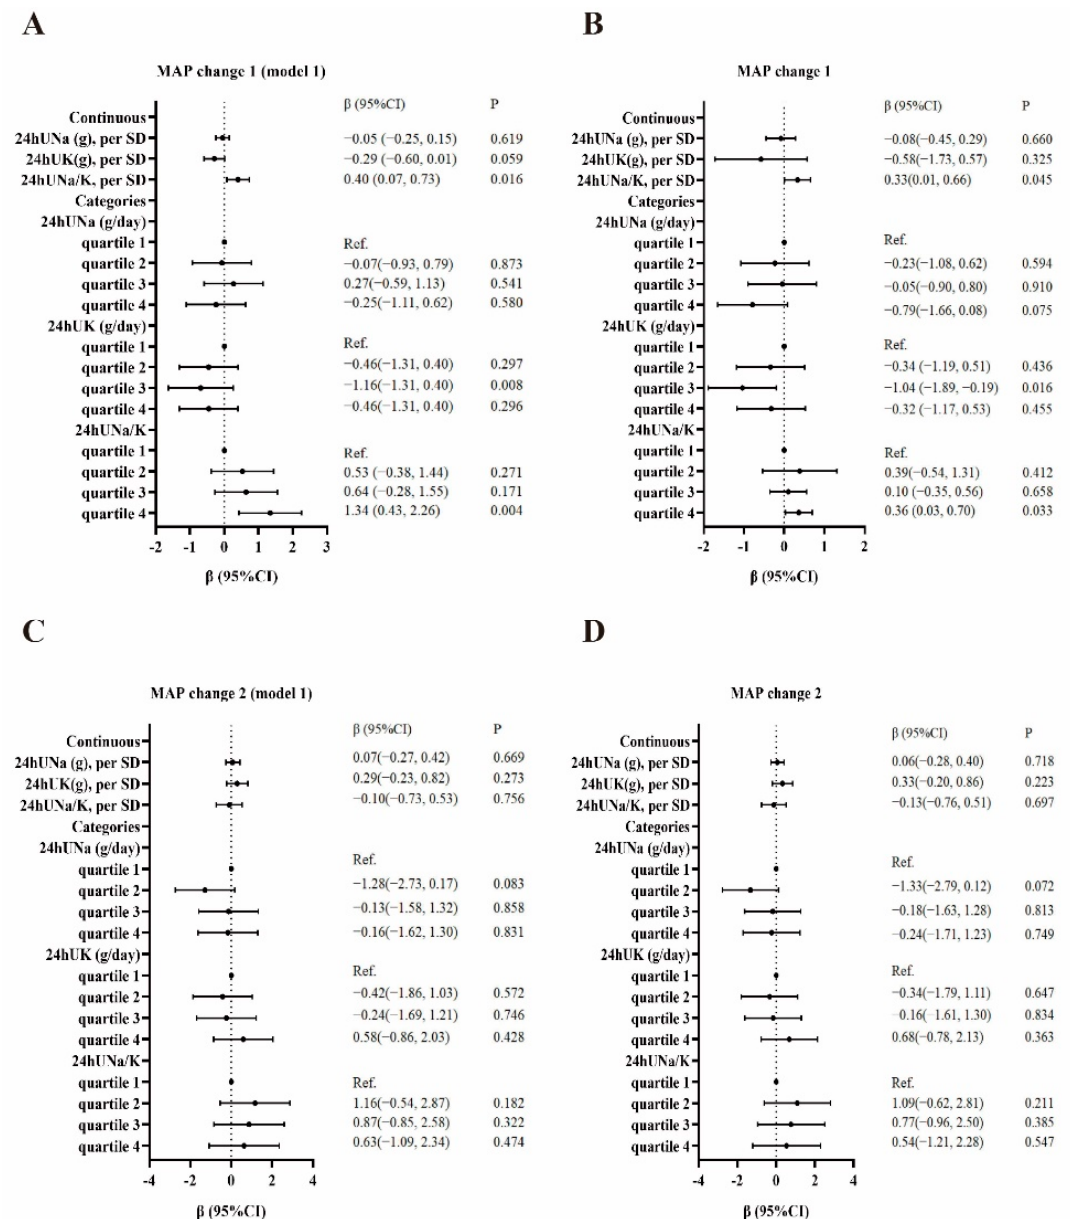
Figure 1. Association between sodium, potassium, sodium: potassium ratio, and SSBP. MAP change 1 as the outcome ( A ). MAP change 1 as the outcome and adjusted for age, gender, BMI, FBG, and baseline MAP ( B ). MAP change 2 as the outcome ( C ). MAP change 2 as the outcome and adjusted for age, gender, BMI, FBG, and baseline MAP ( D ).